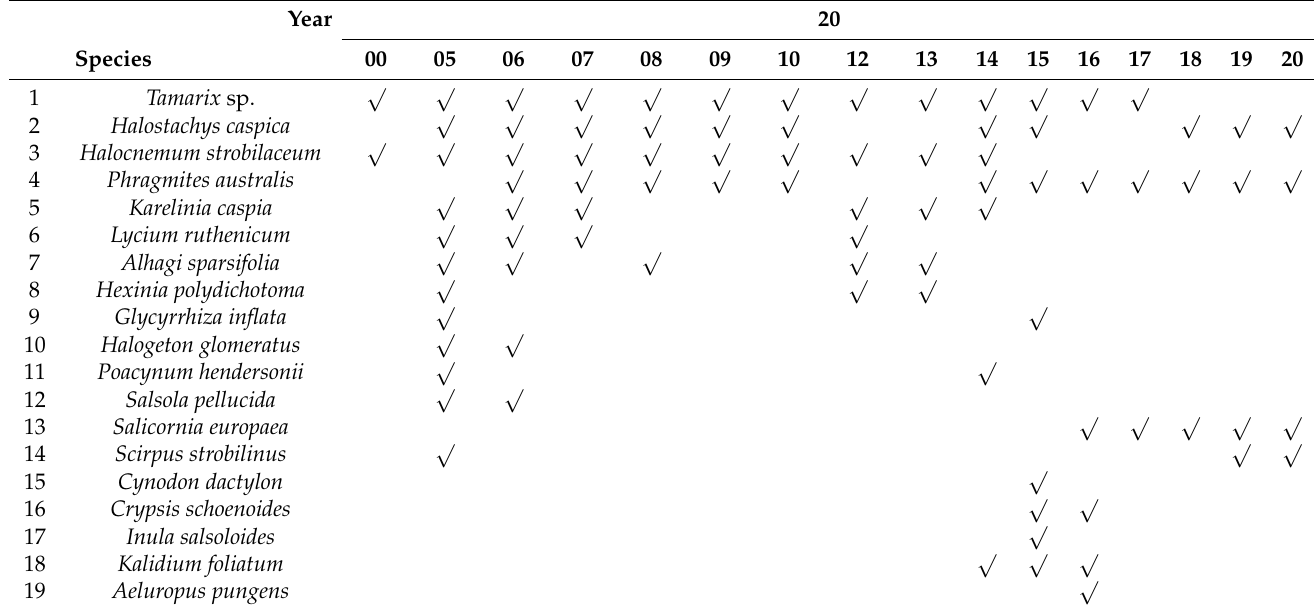
Table 2. List of species present in quadrats for each year (2000, 2005–2020).